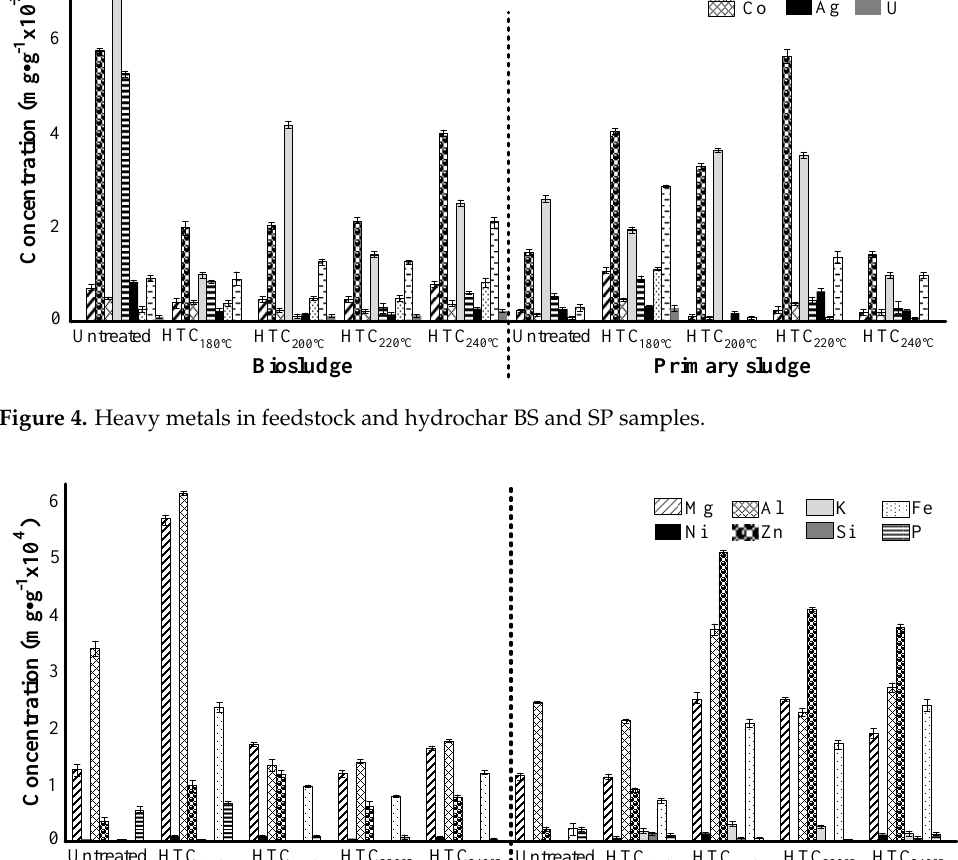
Figure 5. Inorganic elements in feedstock-liquor and HTC-liquor of BS and SP samples.